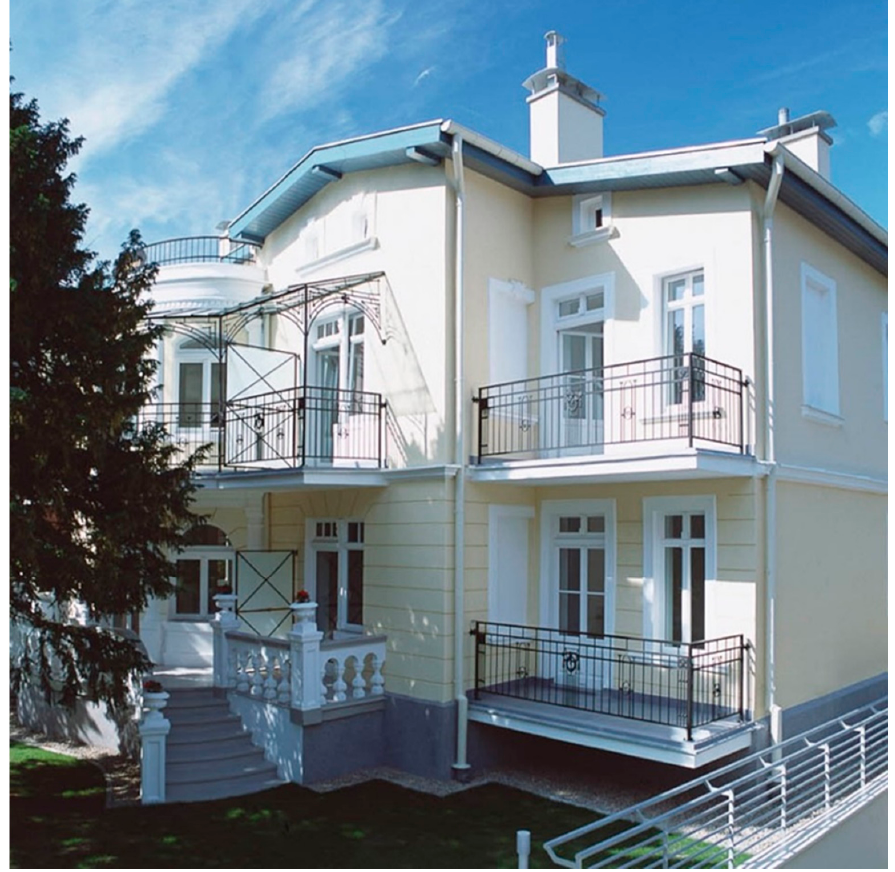
Figure 13. Historical part of Willa Halina. Front elevation after revitalization. Source: FORT Taraszkiewicz Architekci.